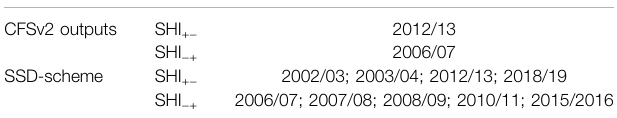
TABLE 3 | The correctly predicted SH reverse year based on CFSv2 outputs and SSD-scheme. CFSv2 outputs SHI +